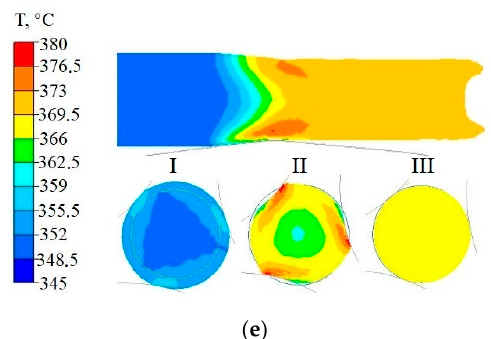
Figure 9. Distributions of temperature on the longitudinal sections and cross-sections of deformed bars at a temperature of, respectively, ( a ) 150 ◦ C; ( b ) 200 ◦ C; ( c ) 250 ◦ C; ( d ) 300 ◦ C; and ( e ) 350 ◦ C.